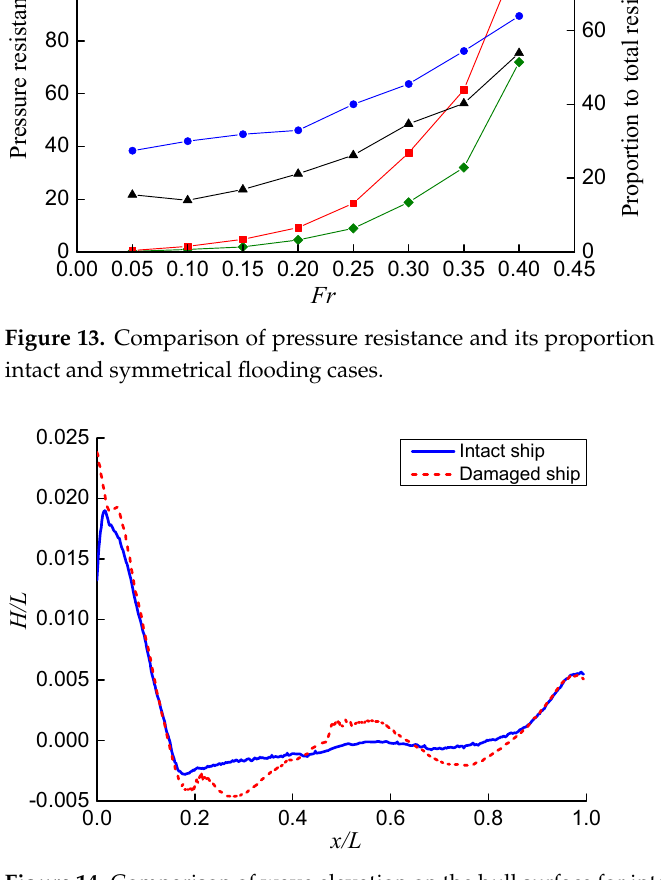
Figure 14. Comparison of wave elevation on the hull surface for intact and damaged ships ( Fr = 0.30). Table 11. Resistances of compartment and hull and proportions to the total resistance under sym- metrical flooding (unit: N).